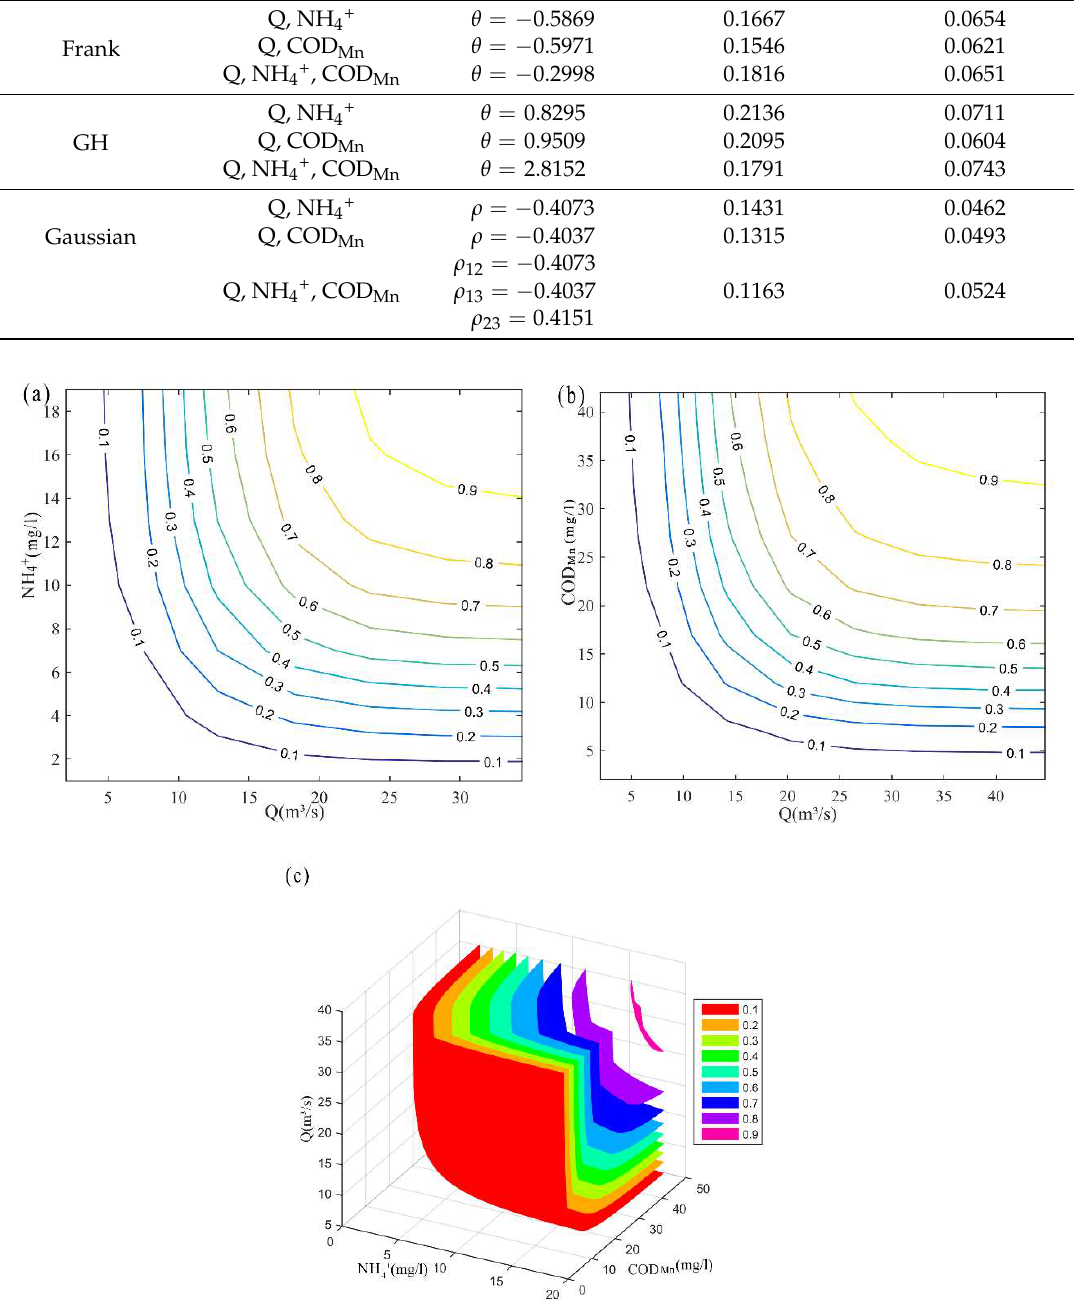
Figure 5. The contour plots and contour surface: ( a ) bivariate joint probability of (Q, NH 4+ ); ( b ) bivariate joint probability of (Q, COD Mn ); and, ( c ) trivariate joint probability of the combination of (Q, NH 4+ , COD Mn ).